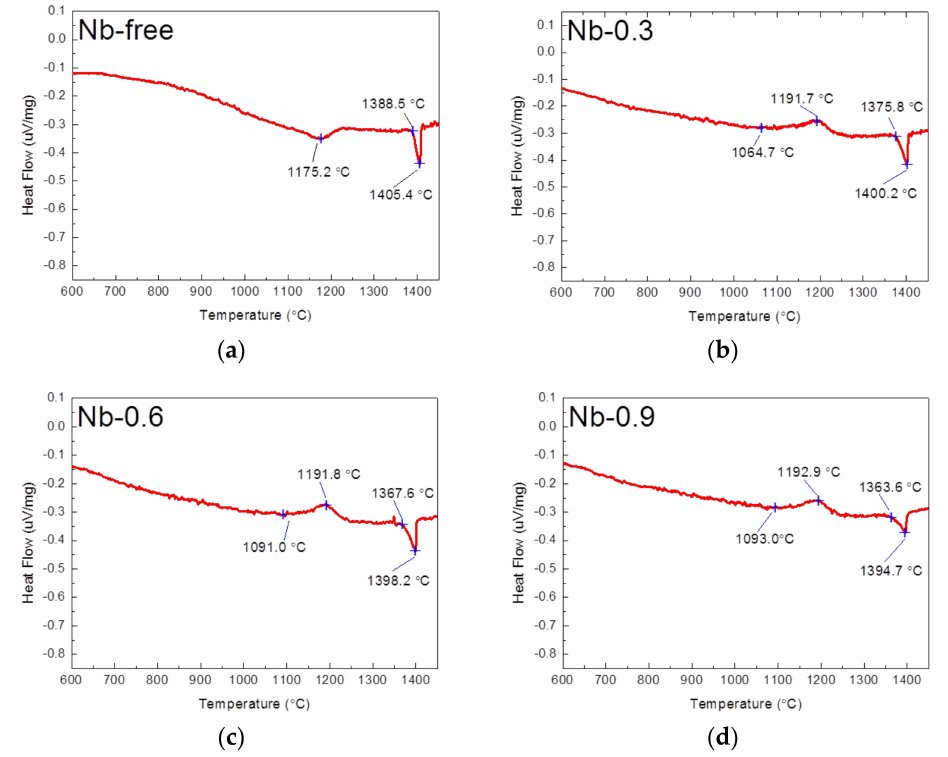
Figure 3. DSC profiles of the 22Cr25NiWCuCo(Nb) steel specimens obtained from thermal analysis: ( a ) Nb-free, ( b ) Nb-0.3, ( c ) Nb-0.6, and ( d ) Nb-0.9 steel